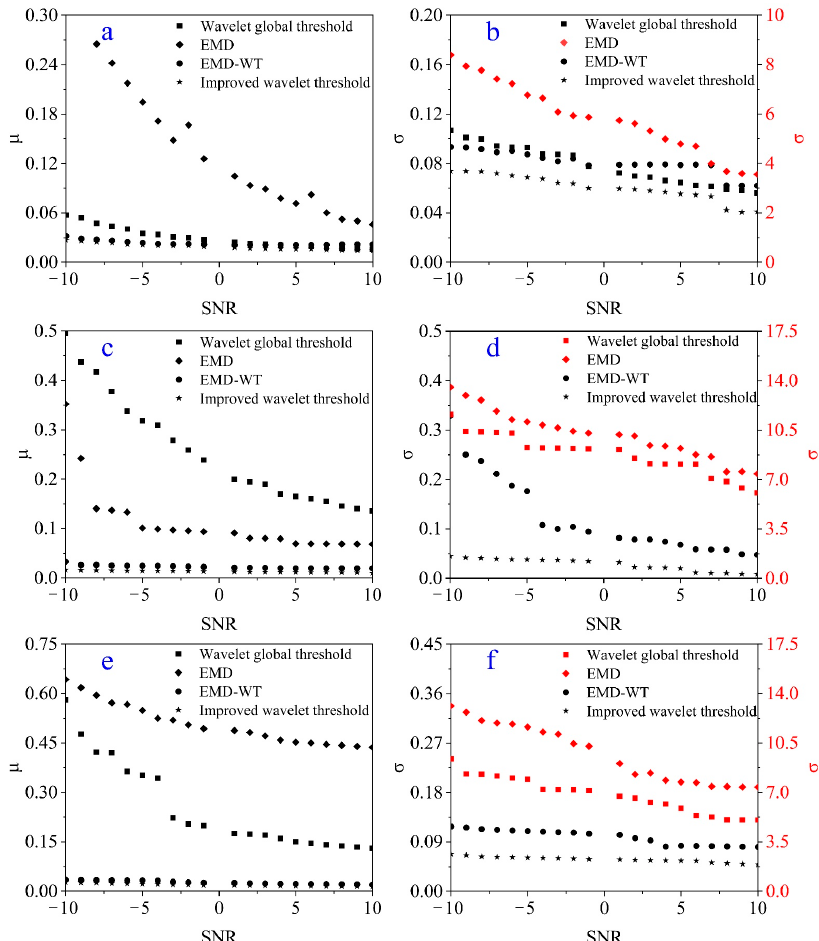
Figure 11. Comparison of different synthetic signal evaluation indicators at different SNRs; ( a ) and ( b ) microseismic noise signal indicators, ( c , d ) microseismic current signal indicators and ( e , f ) microseismic noise current signal indicators.